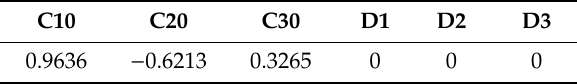
Table 3. Yeoh rubber model